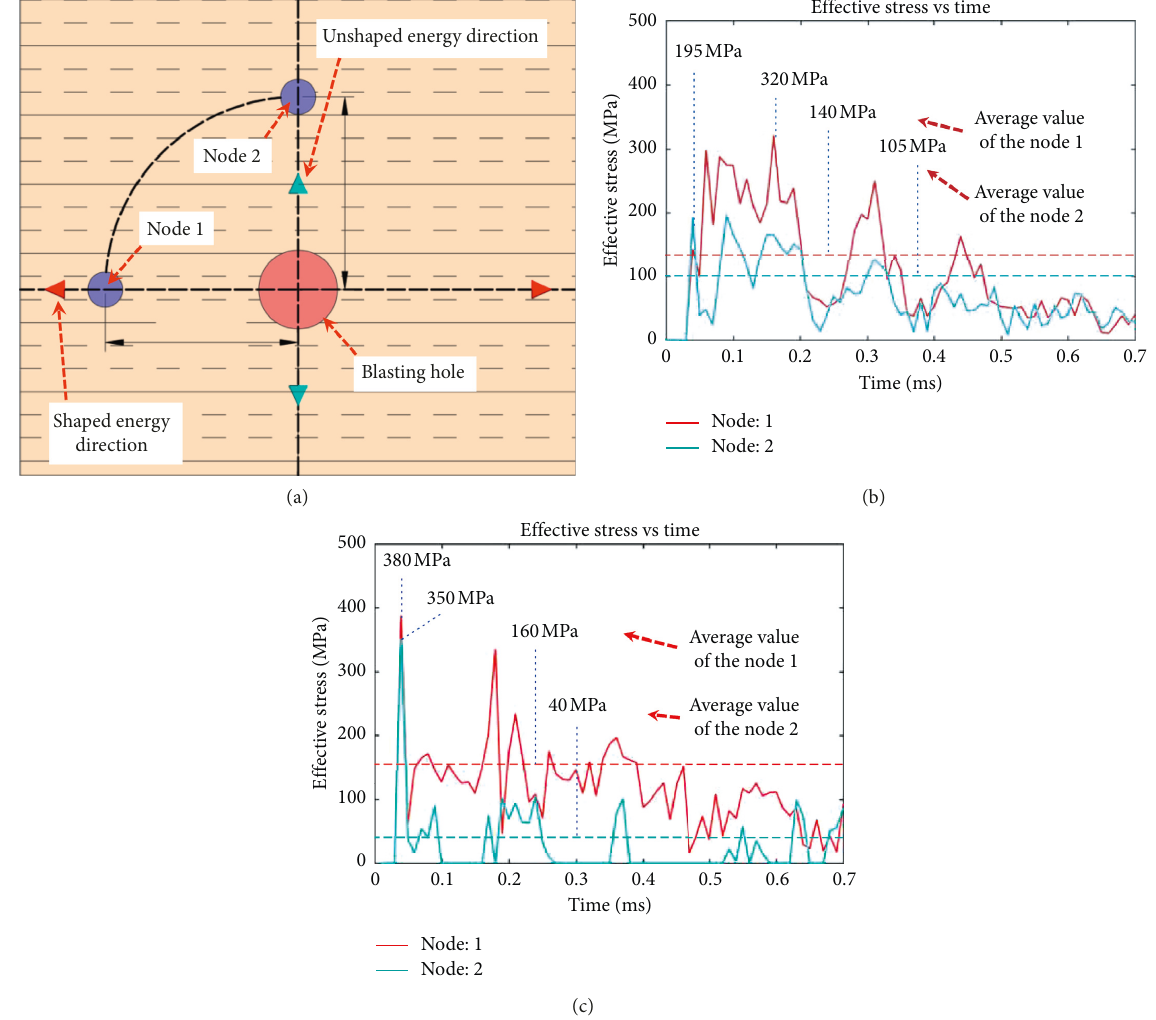
Figure 9: Equivalent stress versus time curve in the direction of energy and the other direction. (a) Schematic diagram of the measuring point position. (b) Conventional SPH method. (c) Automatic adaptive optimization